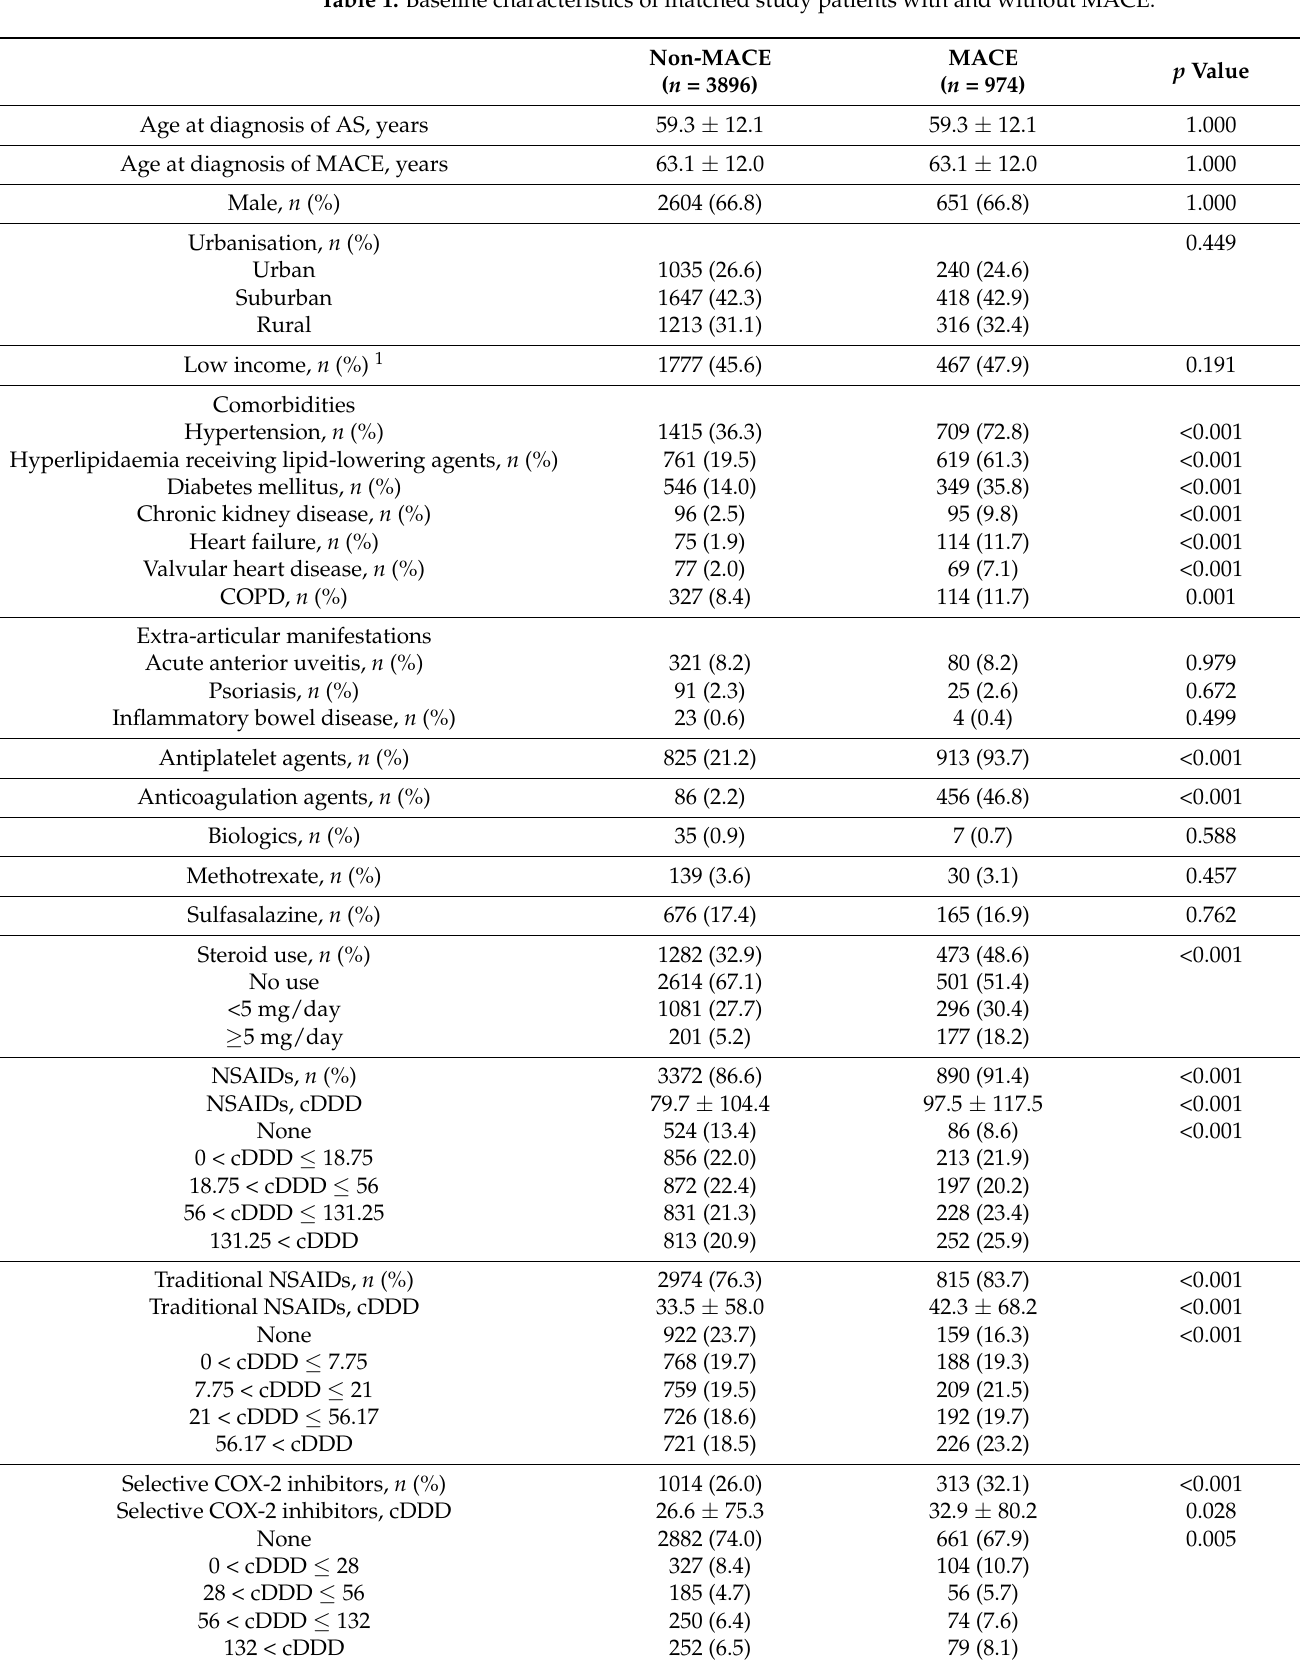
Table 1. Baseline characteristics of matched study patients with and without